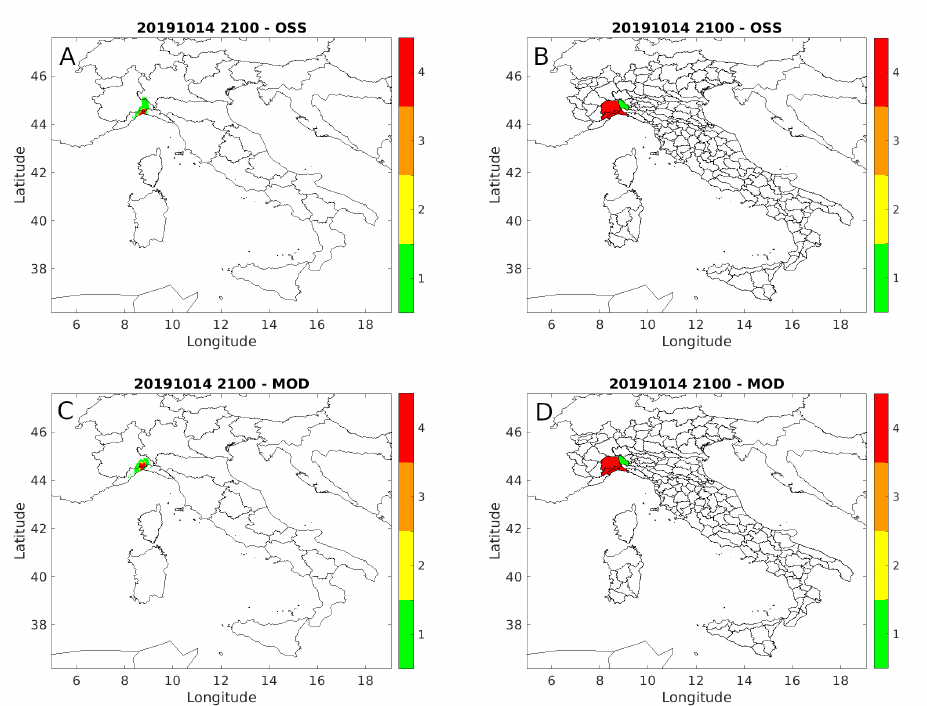
Figure 10. Scenario generated for the 14 October 2019 event at 21 UTC. Panels ( A , B ) refer to observed scenario, panels ( C , D ) to the modeled one.